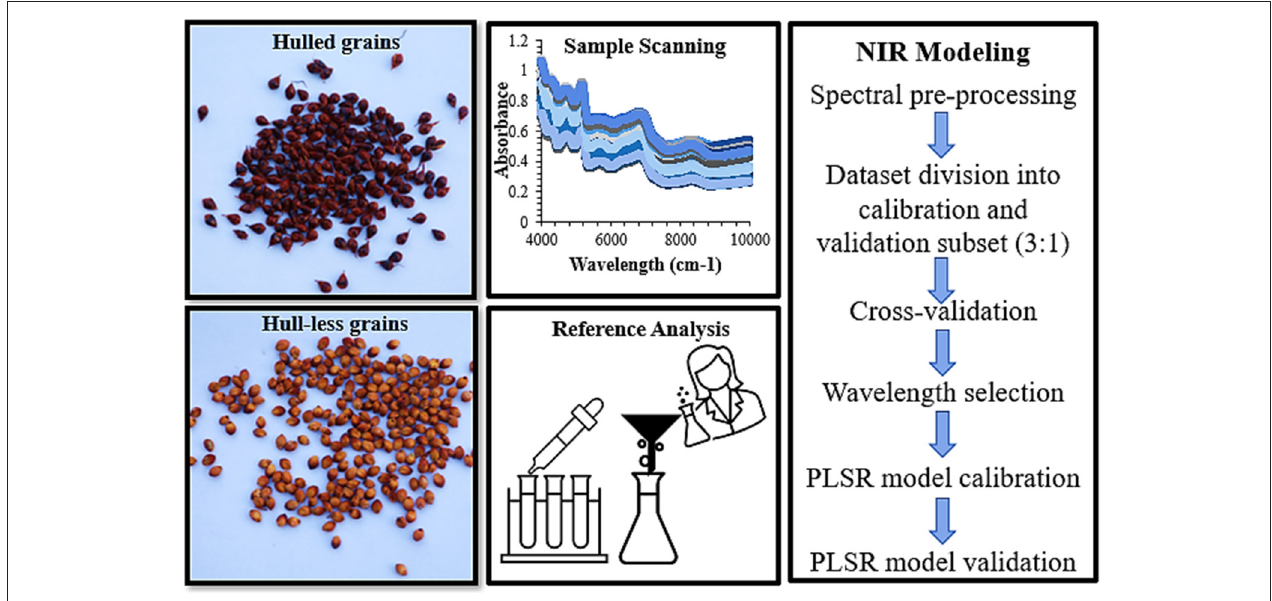
FIGURE 1 | The morphological classification of sorghum grains by means of hulled and hull-less grains, also used as whole grains and flours by means of Fourier Transform near-infrared spectroscopy (FT-NIR) spectral data collection followed by reference analysis. The spectra were processed by combination of pre-treatments, cross-validated, calculation of principal components (PCs) by principal component analysis (PCA), divided into calibration and validation subsets and ultimately, partial least square regression (PLSR) models were built using FT-NIR spectral and reference